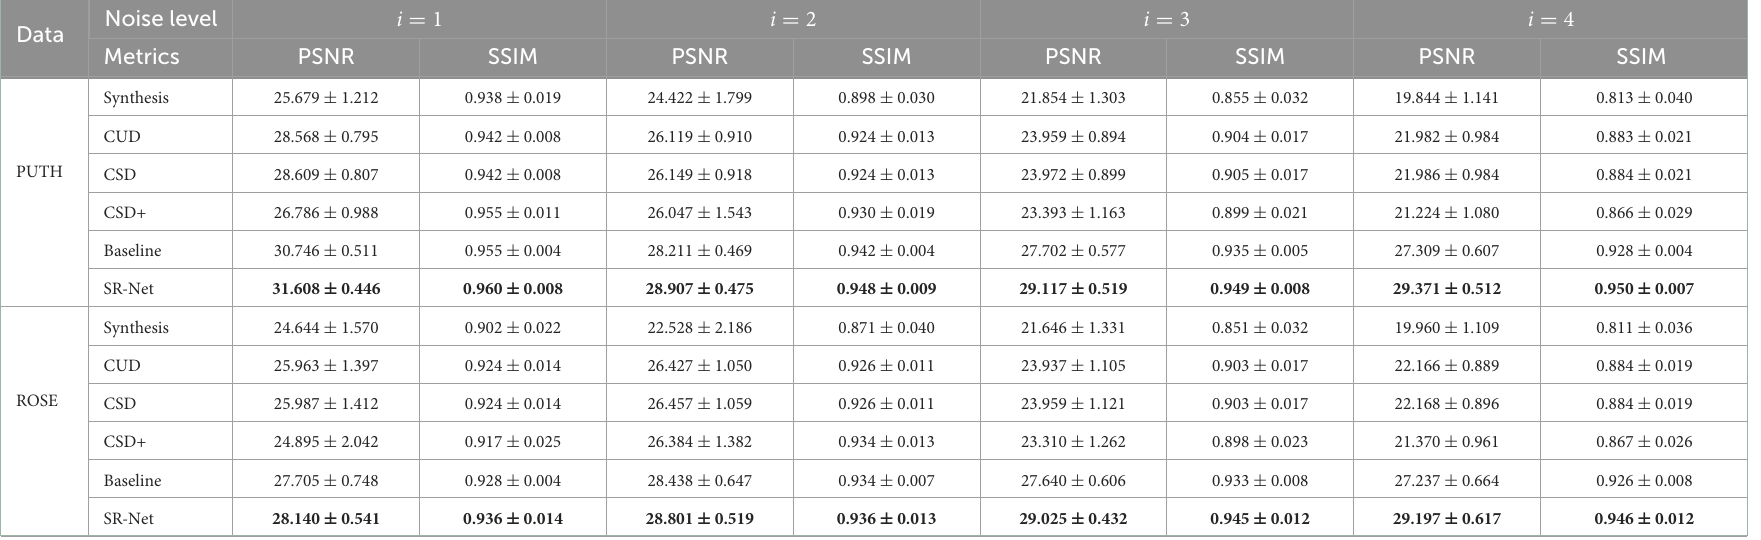
TABLE 1 De-striping performance in ROSE and PUTH dataset in terms of PSNR and SSIM.